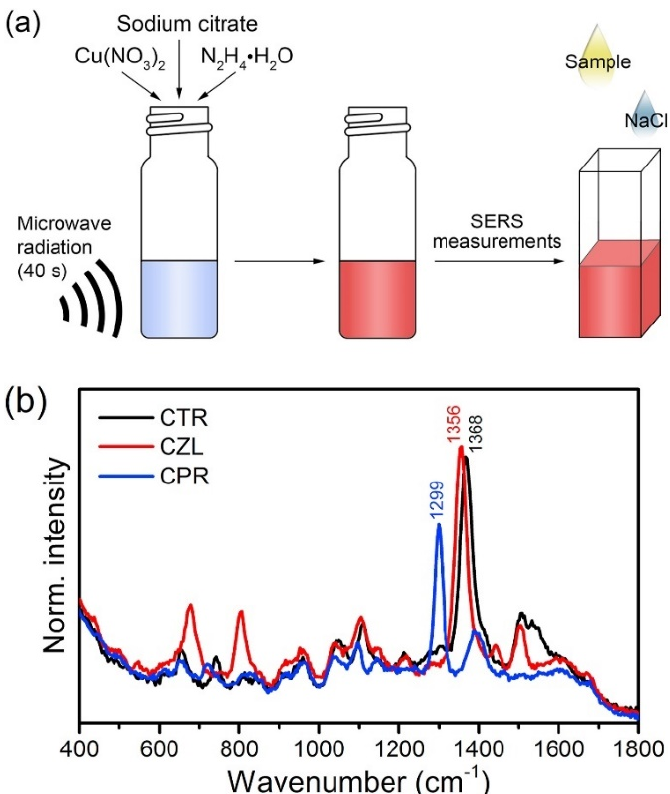
Figure 10. ( a ) Schematic illustration of synthesis of copper nanoparticles and SERS determination of antibiotics in samples of spiked human urine. ( b ) SERS spectra of antibiotics of interest: ceftriaxone, cefazolin, and cefoperazone. Reproduced with permission from [68]. Copyright 2020 Elsevier B.V.